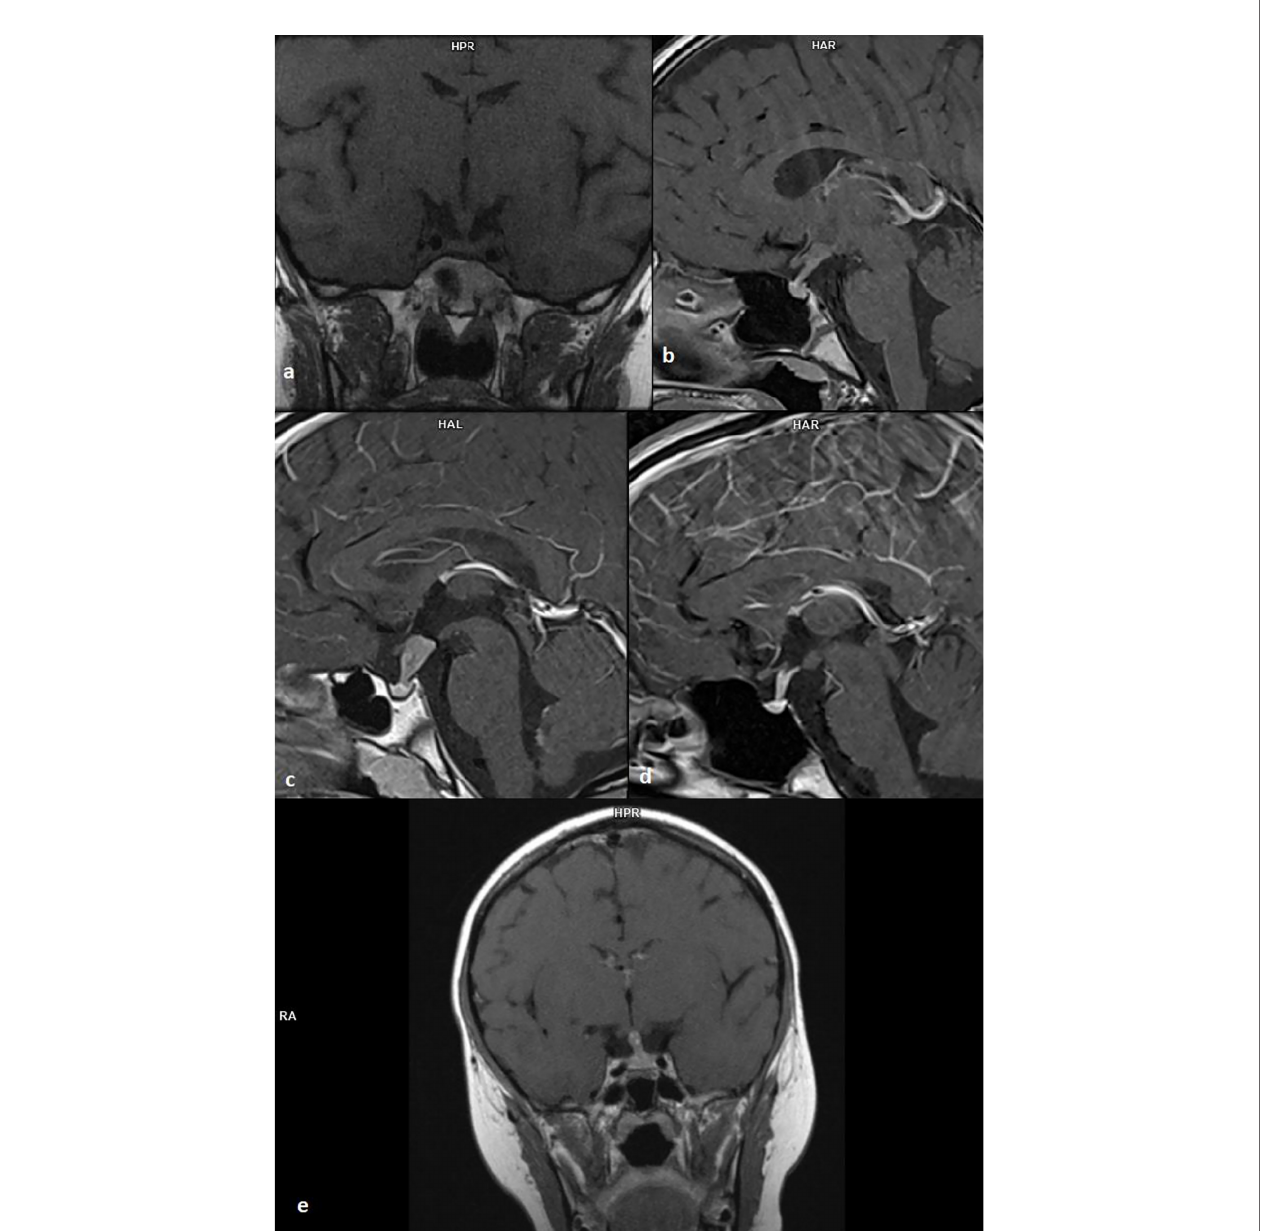
FIGURE 1 | (A) 12-year-old patient with multisystem Langerhans cell histiocytosis, T1 sequence, coronal projection; (B) 9-year-old girl with germinoma, T1 sequence, sagittal projection; (C) 9-year-old boy with recurrence germinoma, T1 sequence, sagittal projection; (D) 14-year-old girl with germinoma, T1 sequence, sagittal projection; (E) 8-year-old boy with germinoma, T1 sequence, coronal